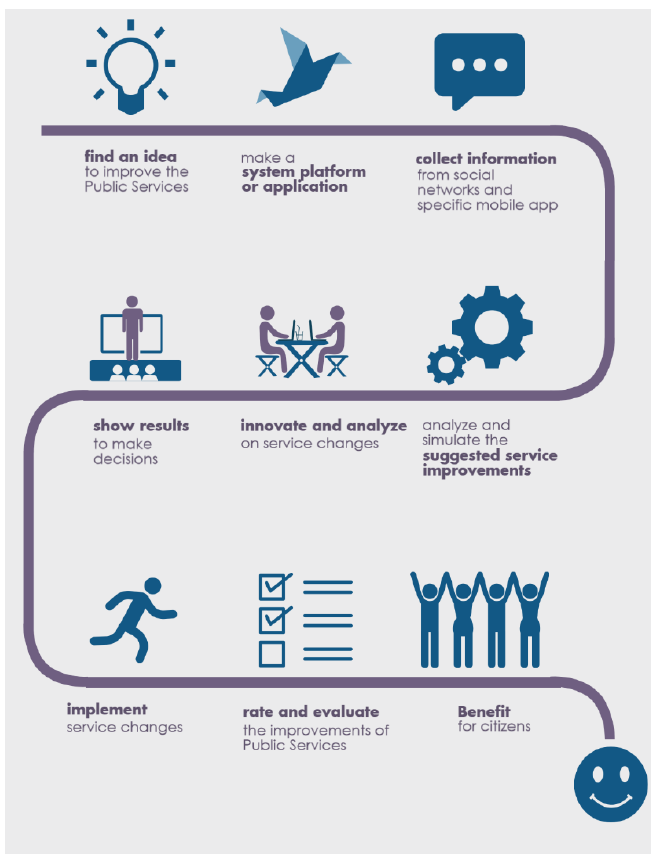
Figure 12. Service process.